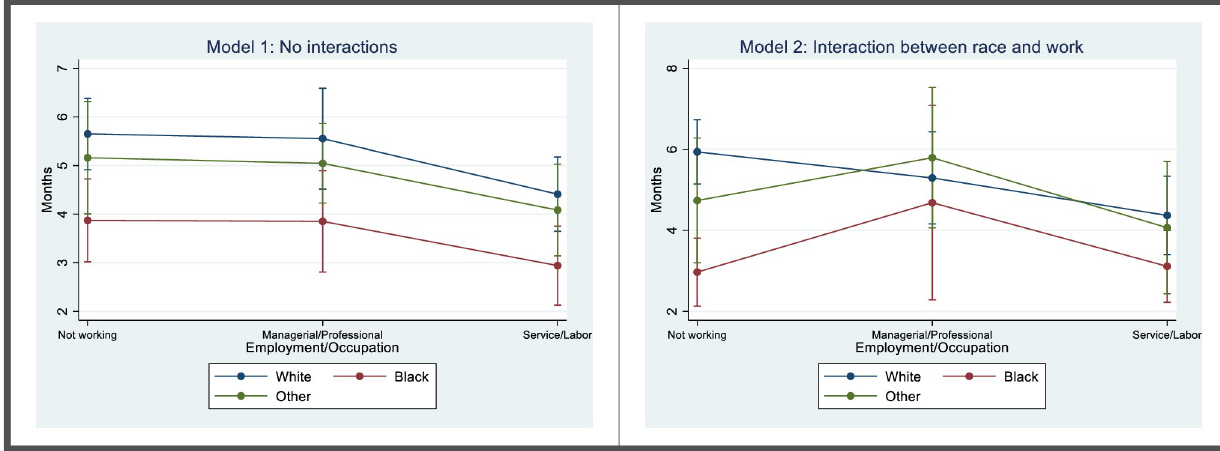
Fig 1. Predicted breastfeeding duration by mother’s employment status/occupation type and race. The predicted margins for breastfeeding duration are based on two adjusted zero-inflated negative binomial regression models: Model 1 predicted breastfeeding duration based on mother’s employment status/occupation type and race with no interaction term, while Model 2 included an interaction between race and employment status/occupation type. Predicted values and confidence intervals are shown in S1–S3 Tables.